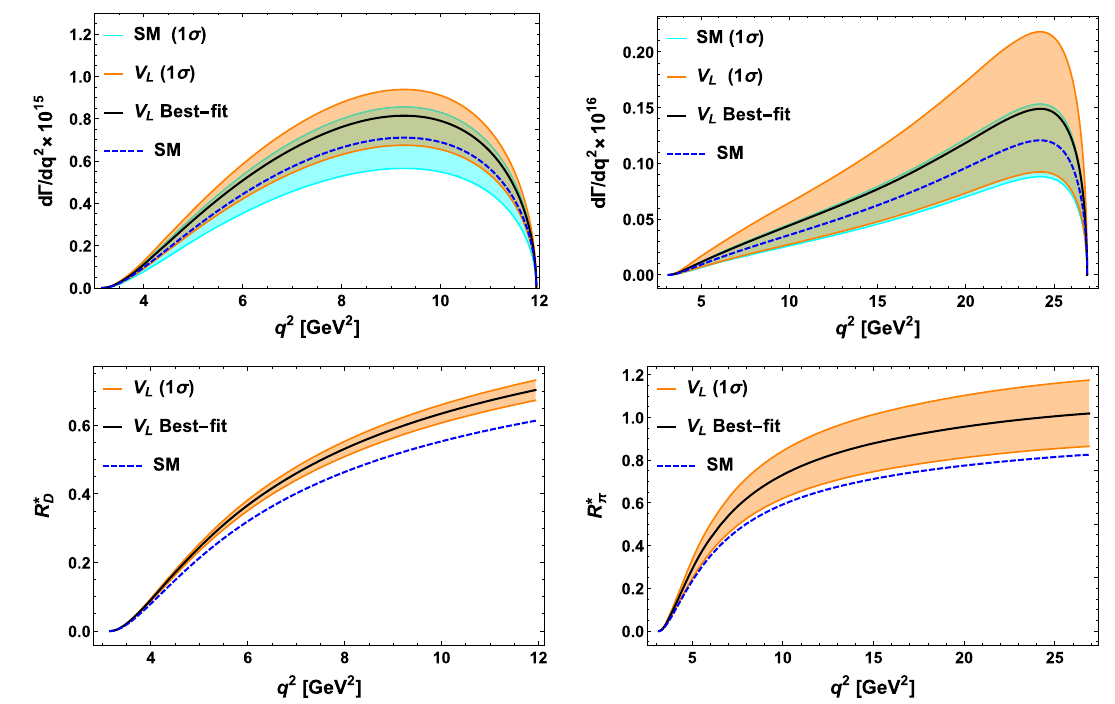
Fig. 3 The q 2 variation of differential decay rates and LNU observ- sentthestandardmodelpredictions.Theblacksolidlinesandtheorange → D + τ − ¯ ν τ (left panel) and ¯ B ∗ → π + τ ¯ ν τ (right panel) in ables of ¯ B ∗ bands are obtained by using the best-fit values and corresponding 1 σ d d presence of only V L new coefficient. Here the blue dashed lines repre- range of V L coefficient